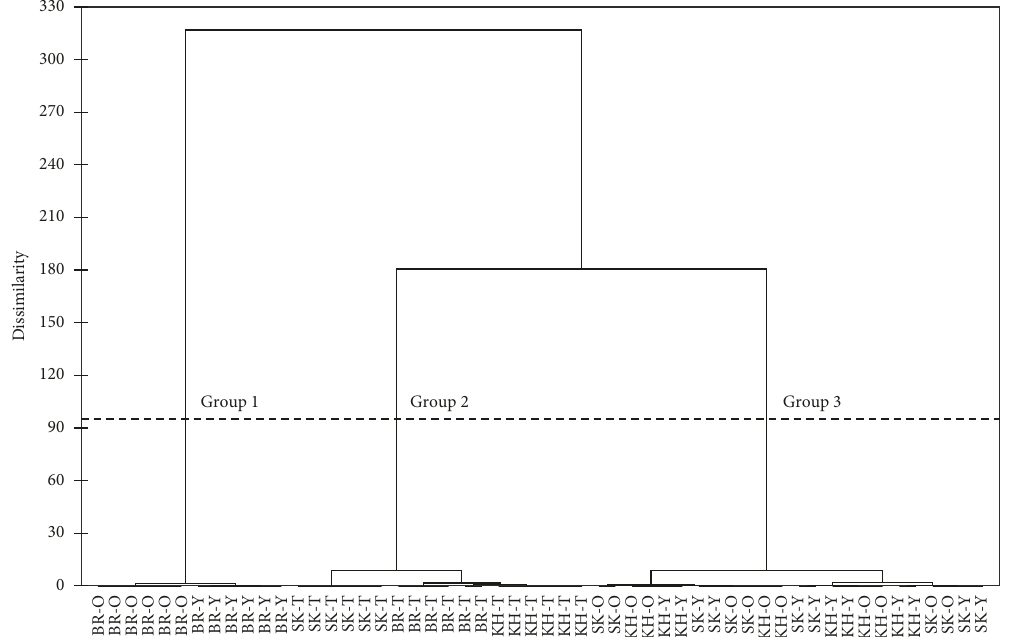
Figure 3: Dendrogram of hierarchical cluster analysis among different samples of mulberry leaves from three cultivars at different mulberry leaves. Cultivar’s codes are BR 60: Buriram 60, SK: Sakonnakhon, and KH: Khunphai. Leaf age’s codes are T: tips, Y: young leaves, and O: old